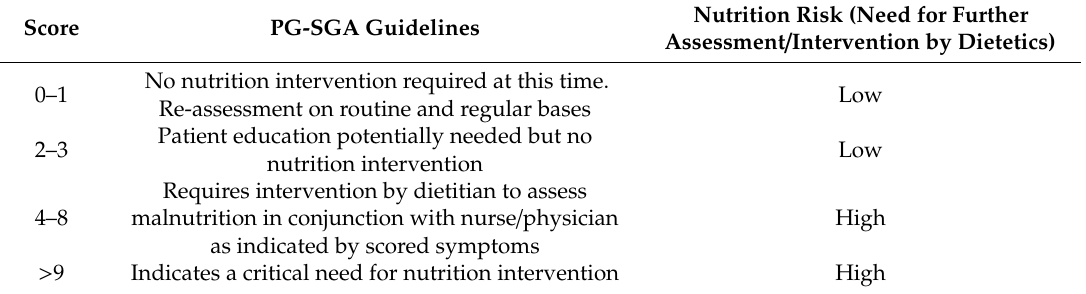
Table 1. Nutrition triage recommendations based on the PG-SGA